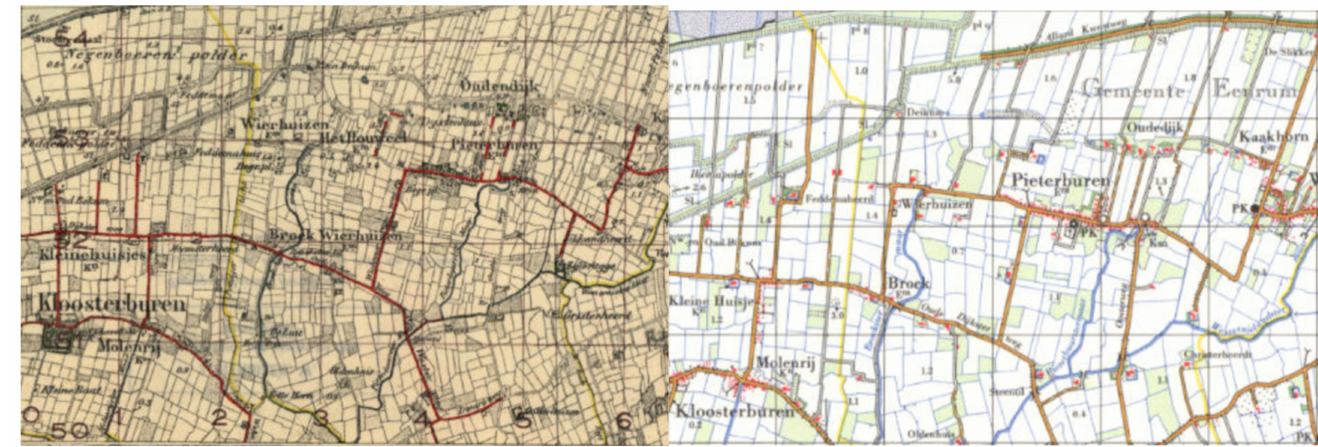
Figure 3. Landscape change in the Marne area as result of land consolidation, situation in 1925 and 1975 (source: J.W. van Aalst,